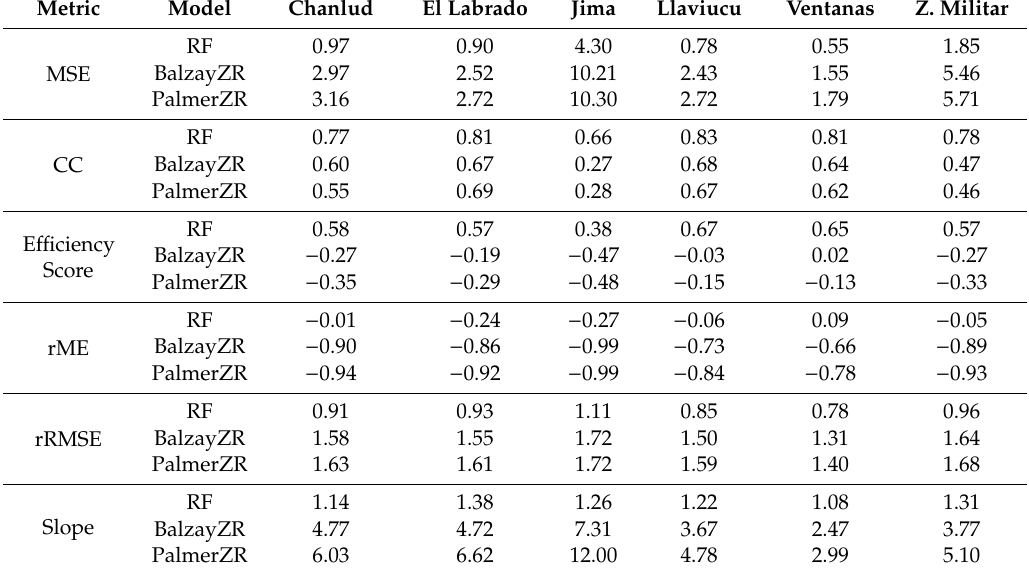
Table 4. Statistical measures of the performance of the di ff erent rainfall retrieval models at all test